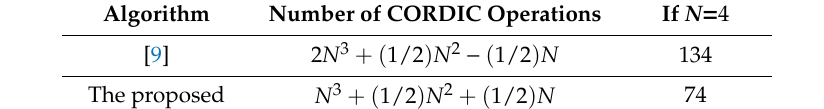
Table 1. Complexity of di ff erent Givens rotation (GR)-based QR decomposition schemes.